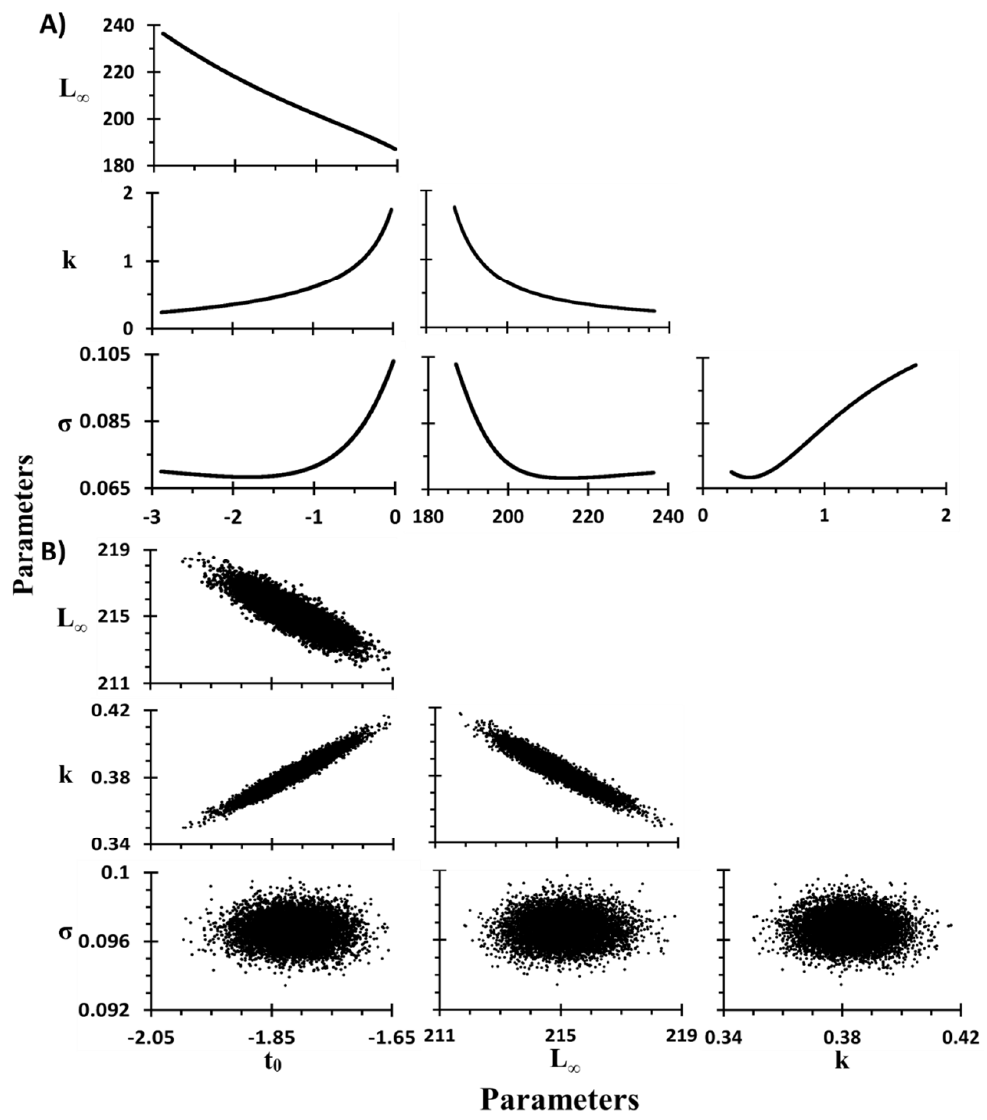
Figure 8. Monte Carlo simulation for parameters estimated by the von Bertalanffy Model of the temperate Sardinops sagax stock considering ( A ) two parameters ( t 0 fixed) and ( B ) three parameters.